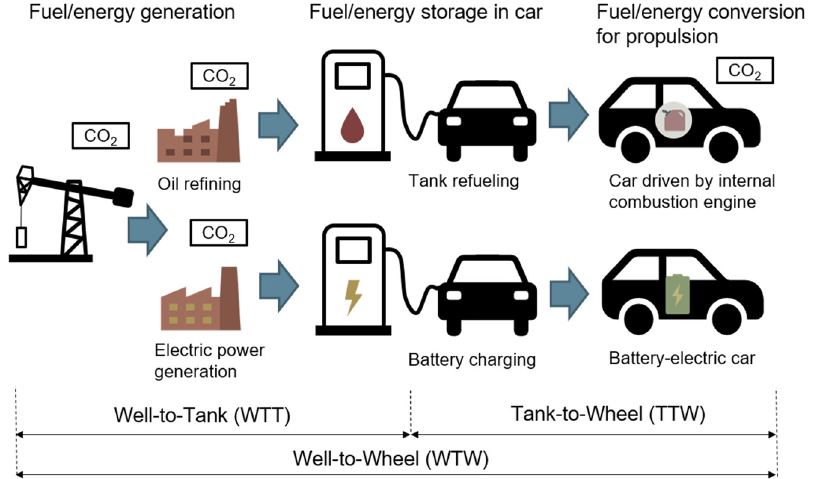
Figure 7. Sequences of energy provision and conversion for vehicle propulsion.